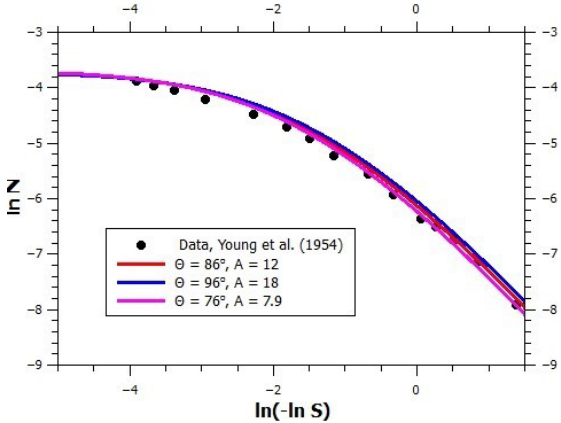
Figure B2. Model fits to adsorption data for three pairs of θ and A .